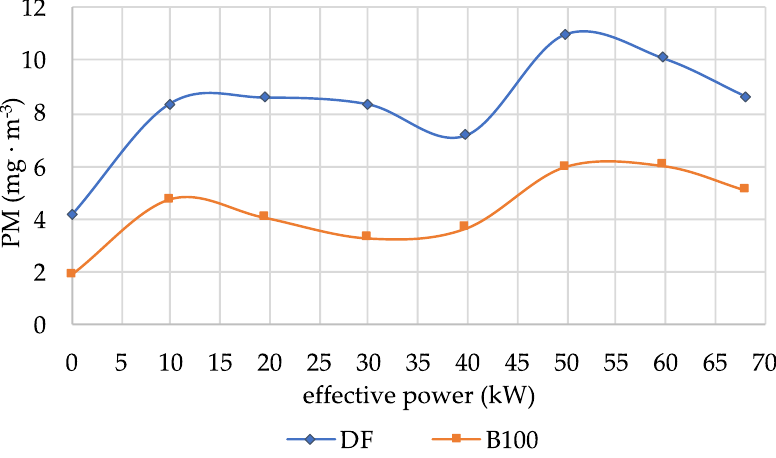
Figure 8. PM emissions vs. the effective power of the John Deere 4045TF285JD engine at 1900 rpm.